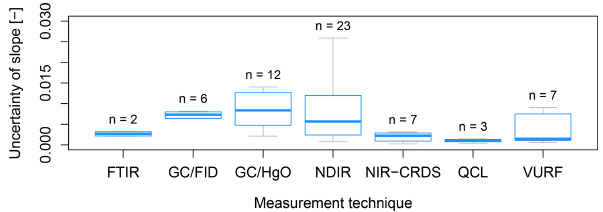
Figure 3. Boxplot of slope uncertainties from the regression anal- ysis for the CO performance audits for different analytical tech- niques including the number of comparisons ( n ). The horizontal blue line denotes the median, and the blue boxes show the inter- quartile